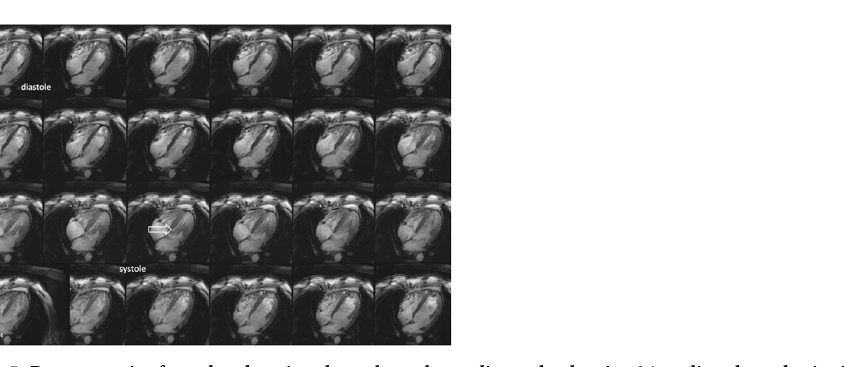
Fig 5. Representative four-chamber view throughout the cardiac cycle, showing 24 cardiac phases beginning and ending with diastole. During systole, prominent flow artifacts in the intracavitary blood volume are detected (white arrow).